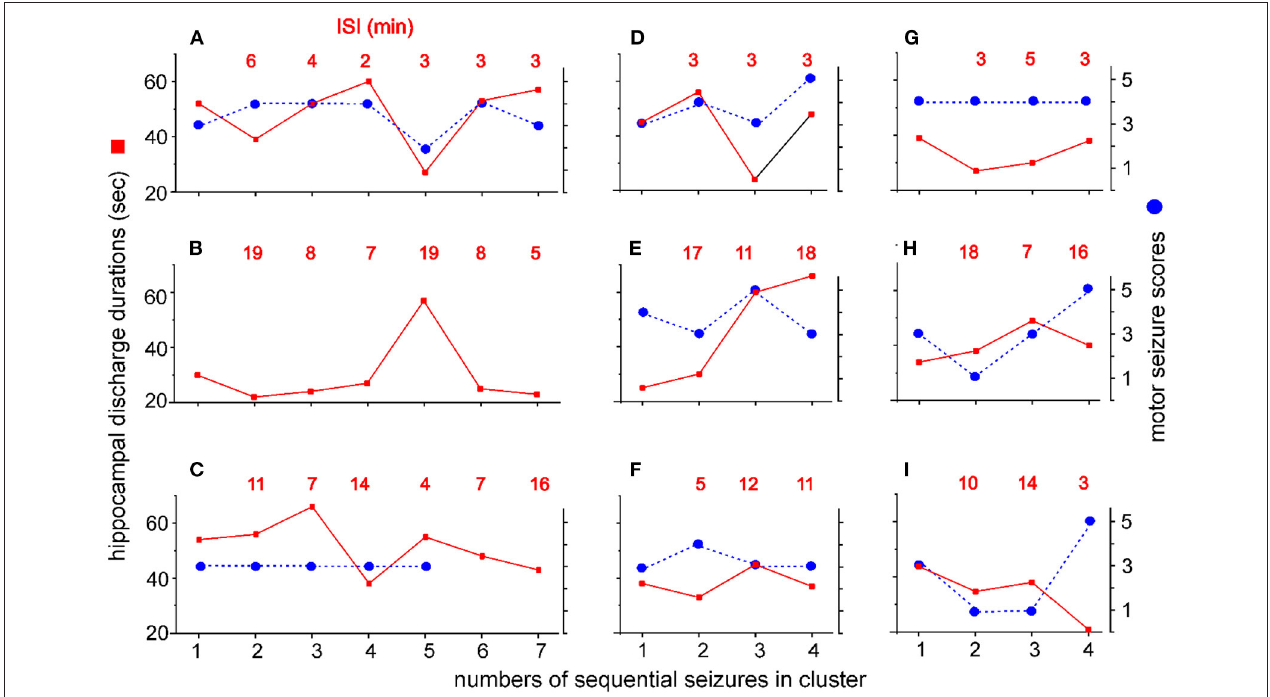
FIGURE 6 | Intra-cluster seizure severities and ISIs. Seizure clusters with ≥ 4 seizures per cluster and intra-cluster ISIs ≤ 20min were observed from 9 mice. Y axis - discharge durations of the kindled hippocampus (red squares, left) and corresponding motor seizure scores (blue circles, right). X axis - numbers of sequential seizures in cluster. Intra-cluster ISIs are indicated by red letters in each plot. Data were plotted for individual mice (A – I) . Motor seizure scores corresponding to the discharges in (B) and to the last two discharges in (C) could not be determined due to errors in the video recordings. Note no consistent increase or decrease in discharge durations, motor seizure scores, or ISIs approaching cluster